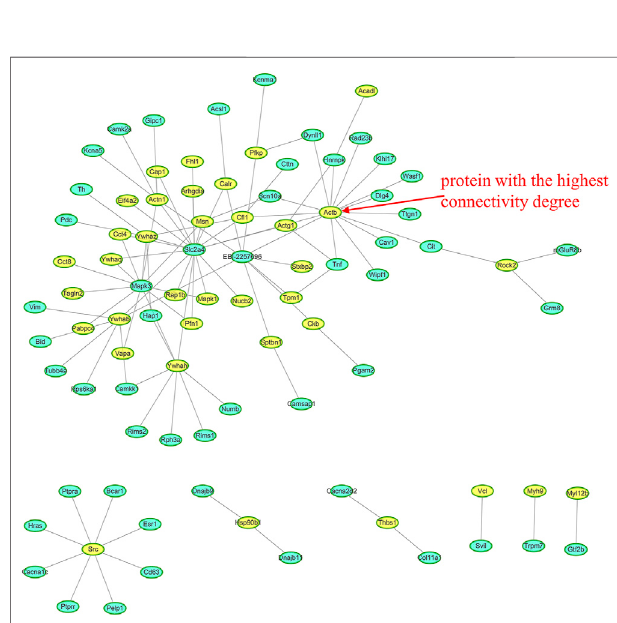
FIGURE 7 | Seven protein-protein interaction (PPI) networks in SMI: Mod. The yellow node represents the differentially expressed proteins (DEPs), and the blue node represents the nonchanged protein. The most complex networkinvolves30DEPsinvolvedandActb(ProteinID-P60711)hasthe highest connectivity degree of